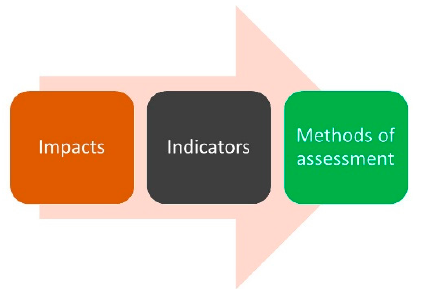
Figure 3. Path for reviewing selected methods of assessment. Source: Authors.